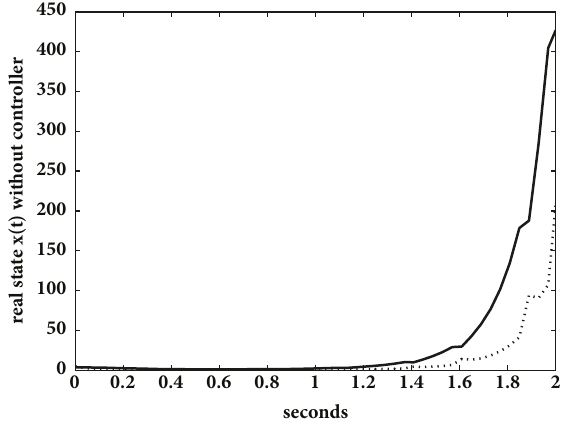
Figure 1: The plot of the jumping modes.